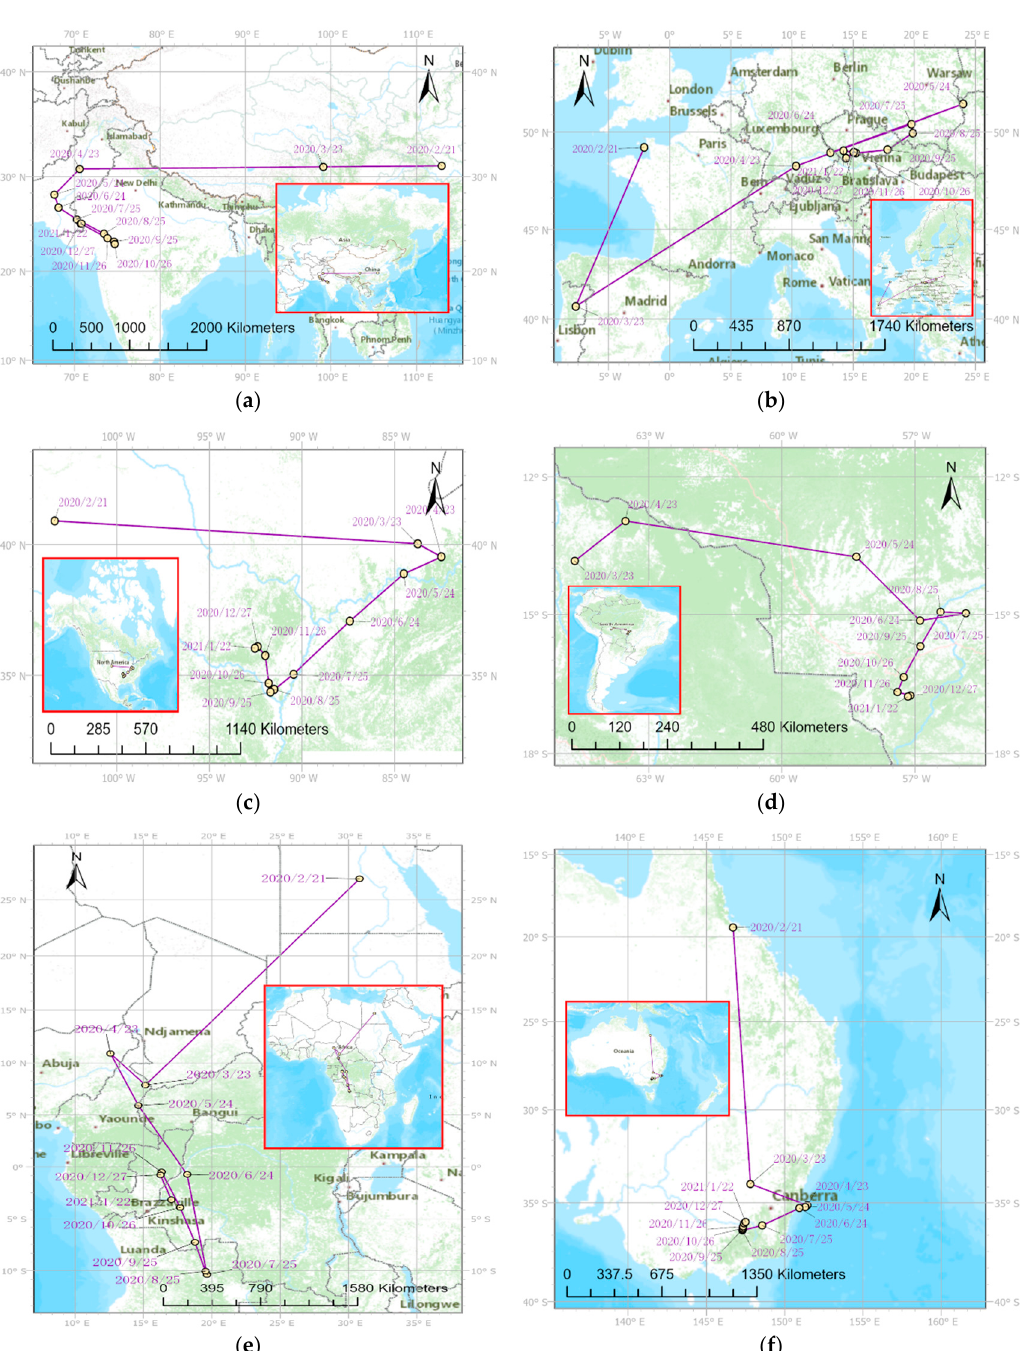
Figure 3. Geographical centroid migration of the COVID-19 pandemic in six continents: ( a ) the geographic mean center migration of the pandemic in Asia; ( b ) the geographic mean center migration of the pandemic in Europe; ( c ) the geographic mean center migration of the pandemic in North America; ( d ) the geographic mean center migration of the pandemic in South America; ( e ) the geographic mean center migration of the pandemic in Africa; ( f ) the geographic mean center migration of the pandemic in Oceania.